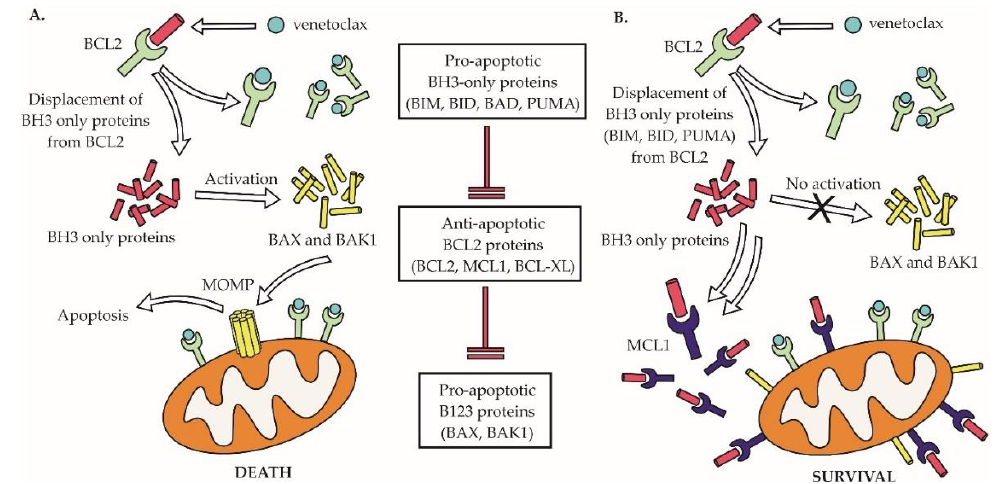
Figure 8. Overexpression of MCL1 is associated with acquired resistance of MCL cells to venetoclax . A . Mode of action of venetoclax in venetoclax-sensitive lymphoma cells. B . Overexpression of MCL1 leads to resistance to venetoclax. BH3—BCL2 homology 3 .